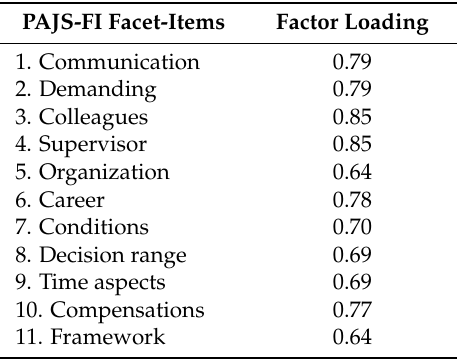
Table 4. Factor loadings in a confirmatory factor analysis for Profile Analysis of Job Satisfaction Facet-Item (PAJS-FI, facet-items, N = 788) 1